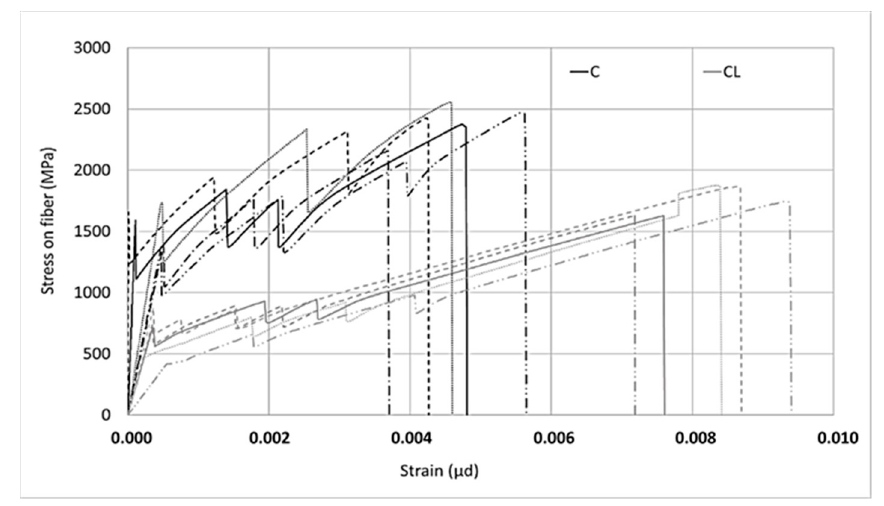
Figure 7. Stress on the fiber–strain relationship of the M60 composite.